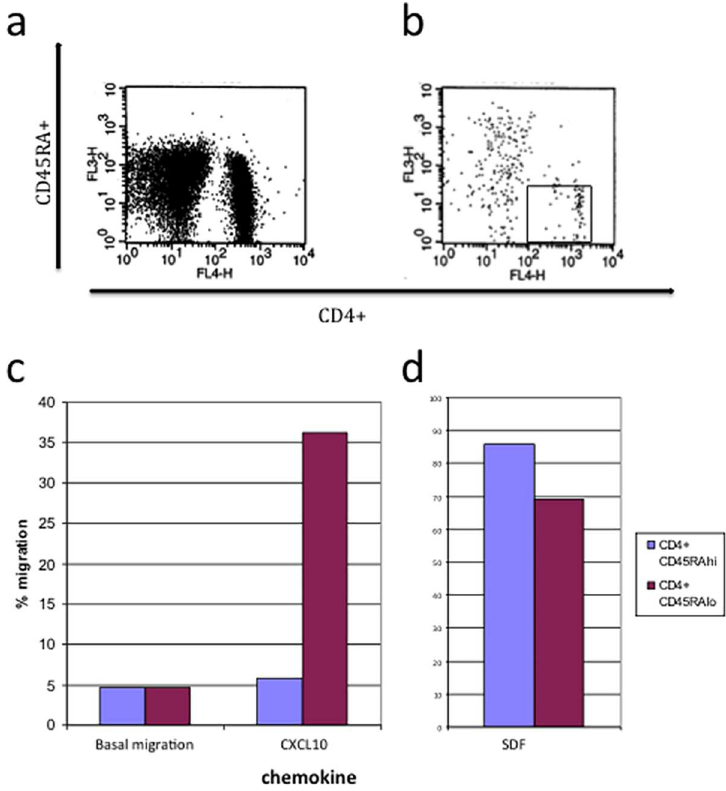
Fig 5. FACS profile of gated lymphocytes labelled with anti-CD4 and anti-CD45RA. migrated to a) 100nMCXCL12(SDF-1alpha) and b) 1 μ g/mlCXCL10. c)/d) The normalised % migrationof input PBMC to CXCL10and CXCL12. Basal migration is the migration to cell culture medium